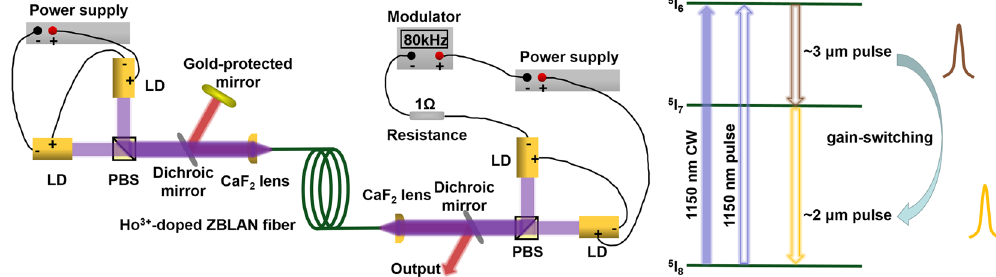
Figure 4. Schematic of the dual-waveband gain-switched Ho 3 + -doped ZBLAN fiber laser. PBS is polarizing beam splitter. Inset: schematic of energy level structure of Ho 3 + -doped ZBLAN fiber and the mechanism of cascaded gain-switching under CW and pulse pumping